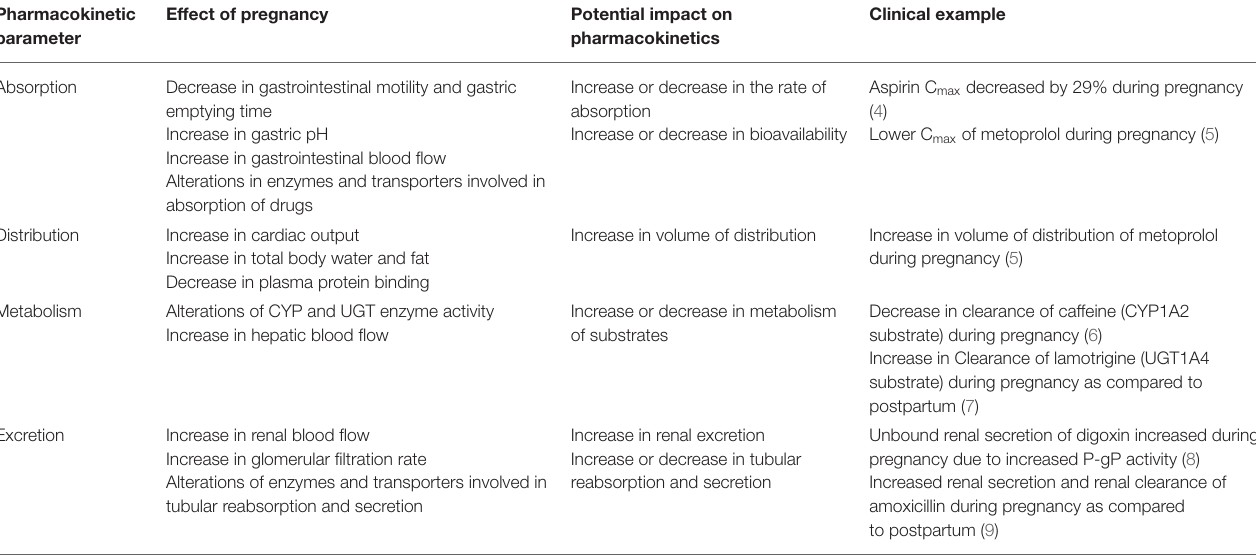
TABLE 3 | Physiological changes and potential impact on PK of